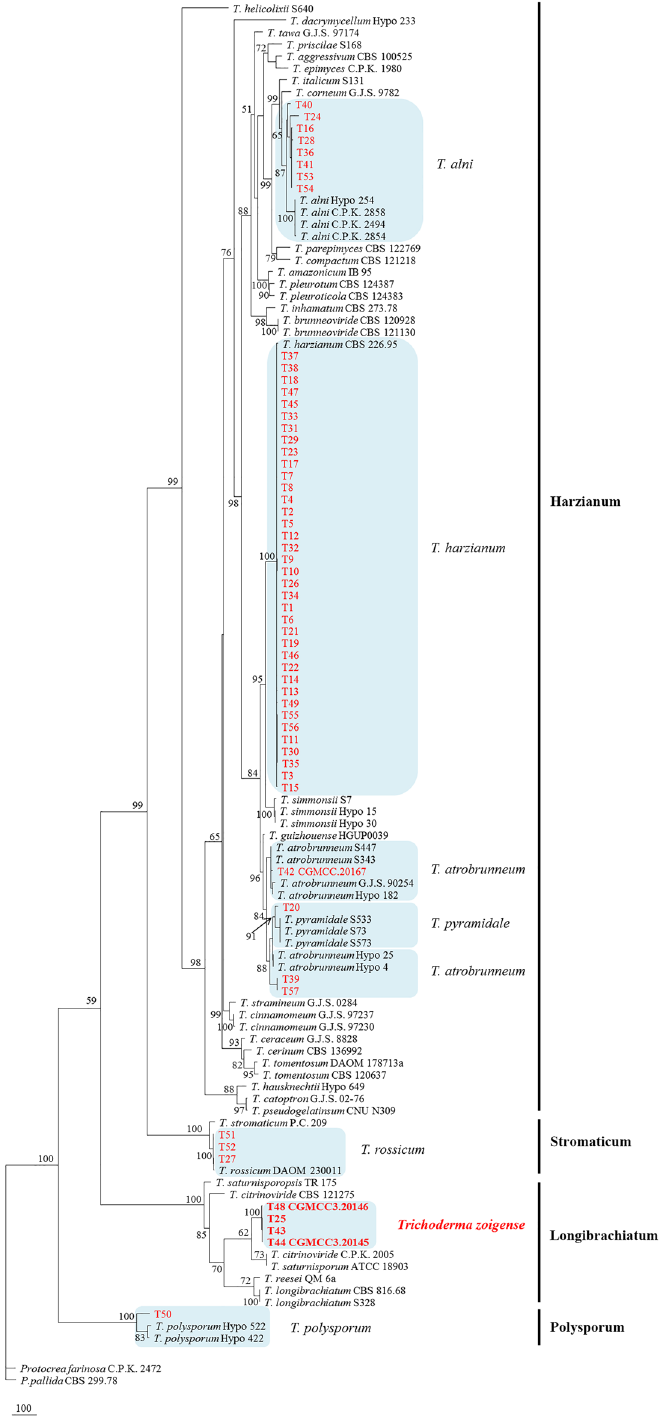
Figure 2. Maximum parsimony tree of Trichoderma species inferred from the combined rpb2 , tef1 and acl1 partial sequences. Maximum parsimony bootstrap values above 50% are shown at nodes. The tree was rooted with Protocrea farinose and P. pallida Isolates from this study are shown in red (new species in